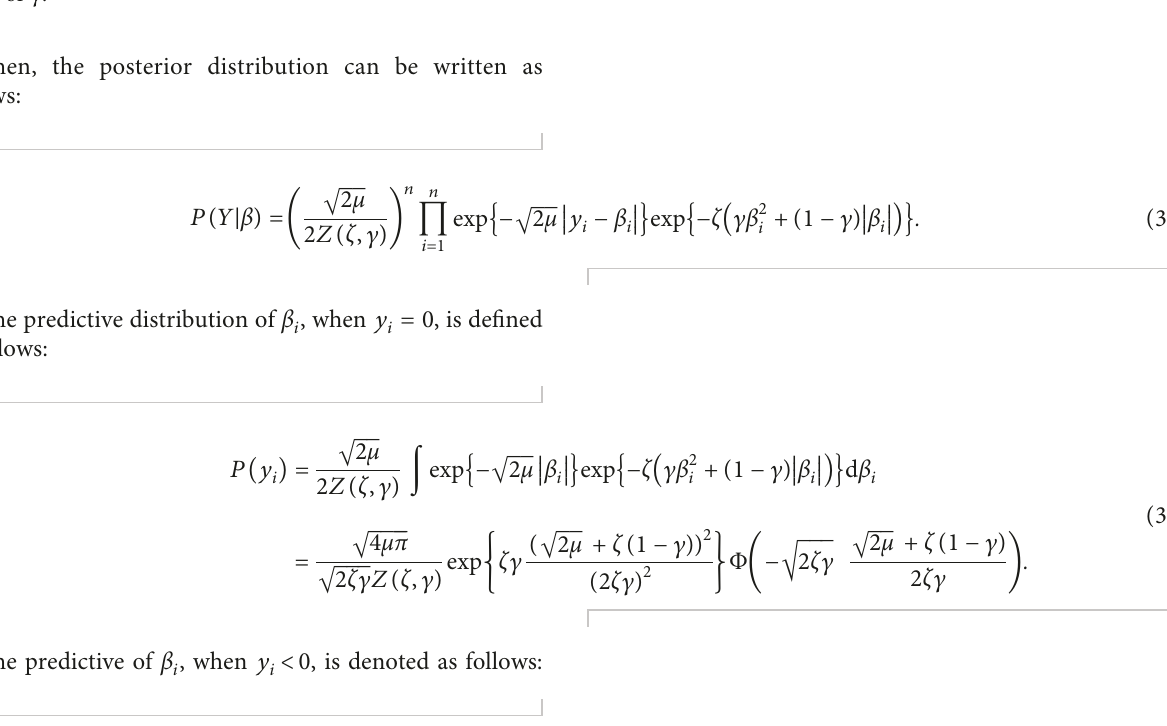
Figure 5: Plots of wavelet coefficients β distribution with different values of c .